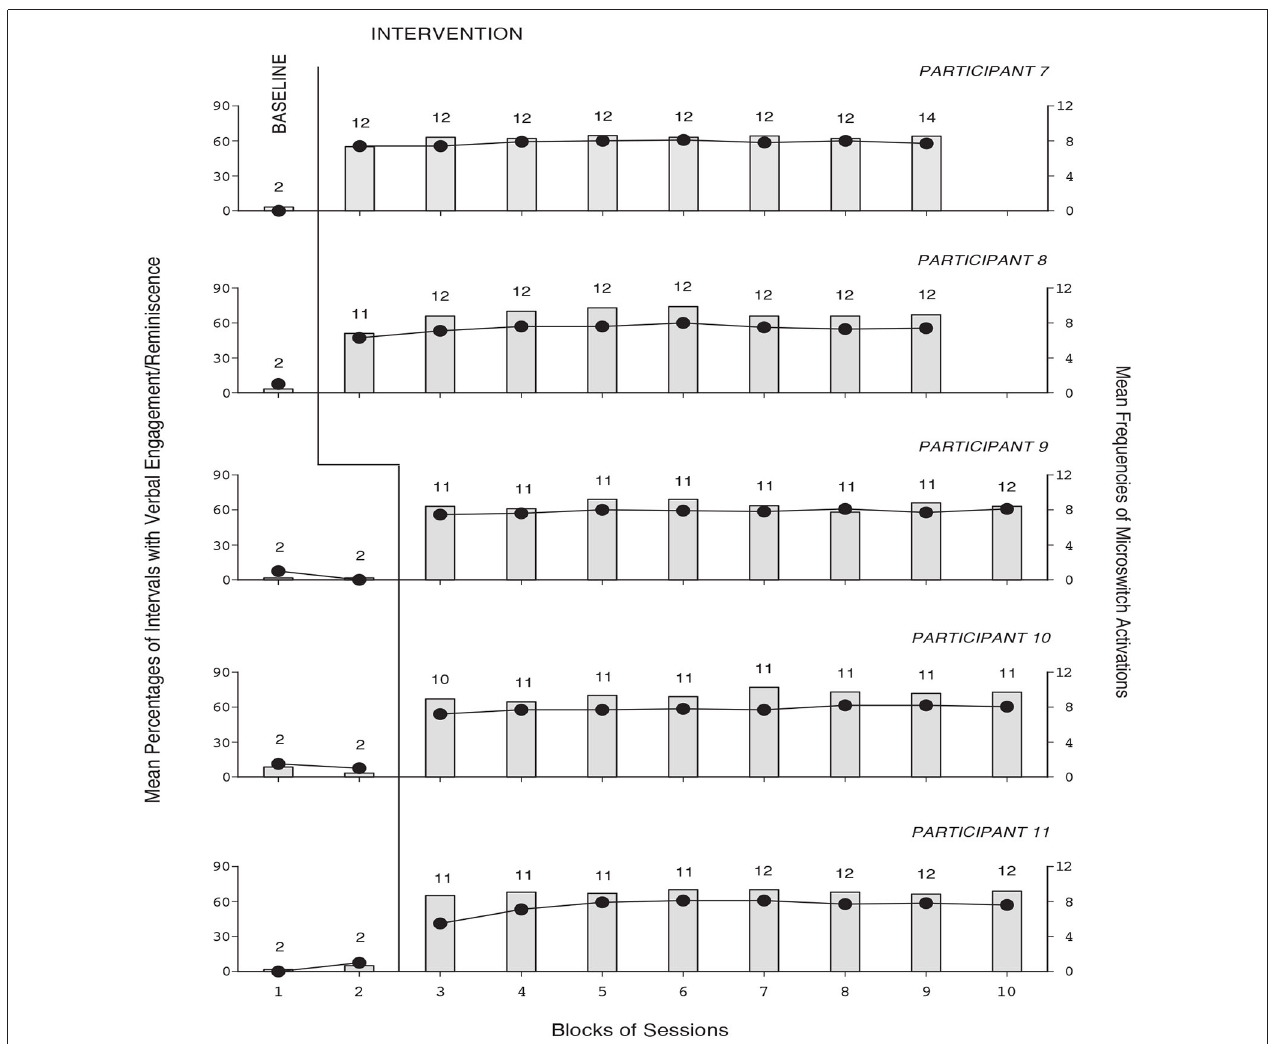
FIGURE 3 | The five panels report the data for Participants 7–11, respectively . Data are plotted as in Figure 1